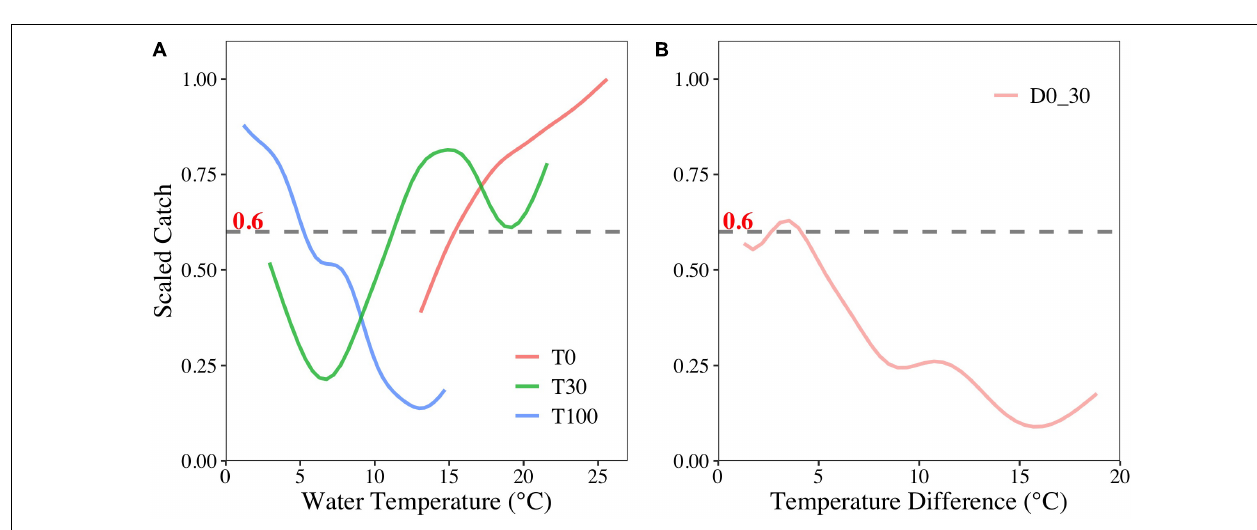
FIGURE 3 | Boxplots of R 2 , α , β , and Akaike Information Criterion (AIC) over 100 cross-validations for the final model.